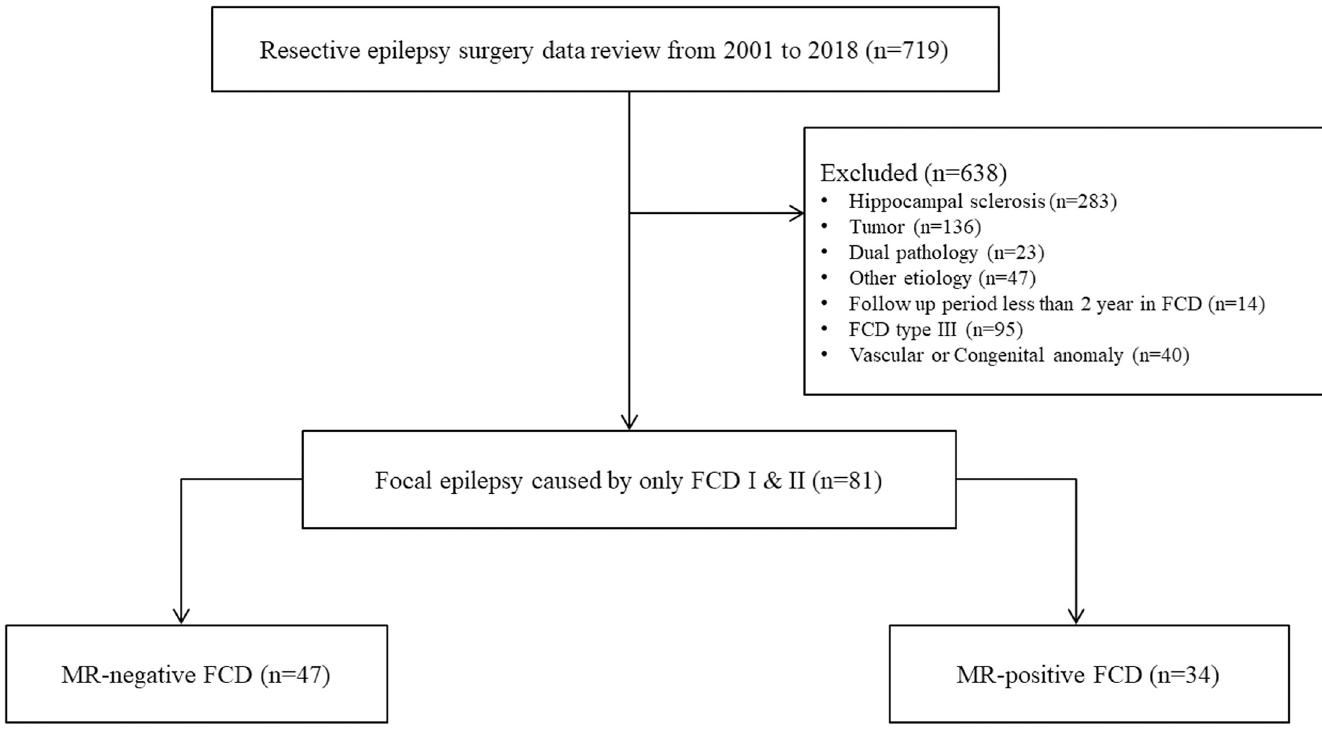
Fig 1. Enrollment log. FCD, focal cortical dysplasia. FCD Type III was defined as FCD Type I adjacent or affecting the same cortical area/lobe to another principal lesion, including hippocampal sclerosis, glial or glioneuronal tumor, vascular malformation, and any other lesion acquired during early life [26].